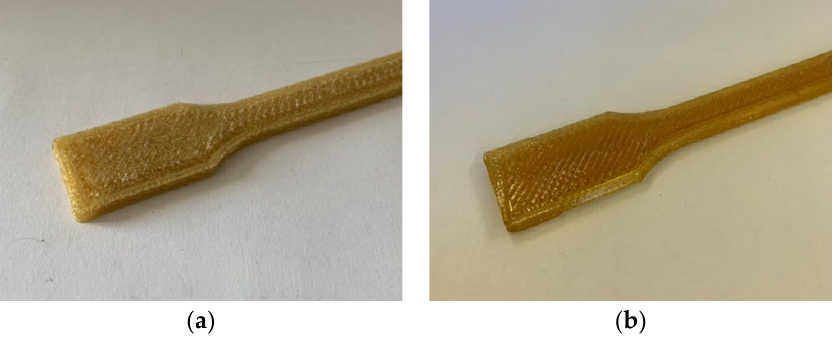
Figure 5. Pictures of undried ( a ) and dried ( b ) specimens. Table 9. Neck section dimensions of dried and undried specimens.